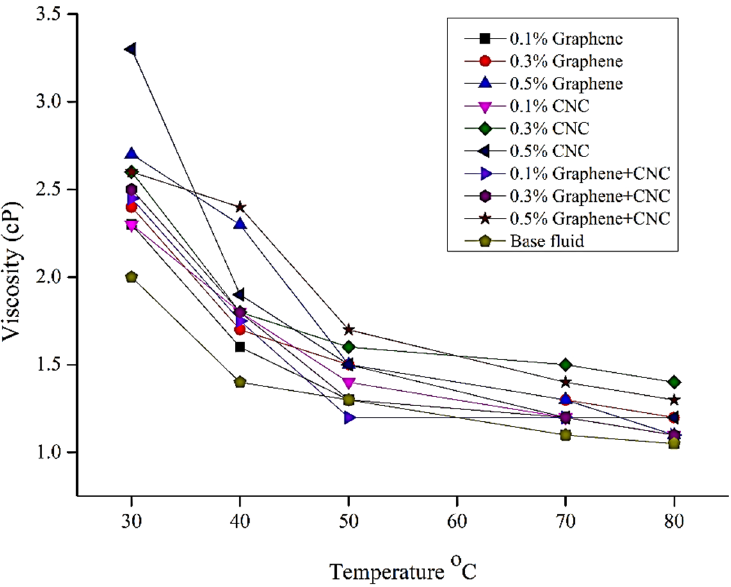
Figure 12. Viscosity (Cp) of graphene, CNC, Graphene+CNC nanofluids, and hybrid nanofluid concerning